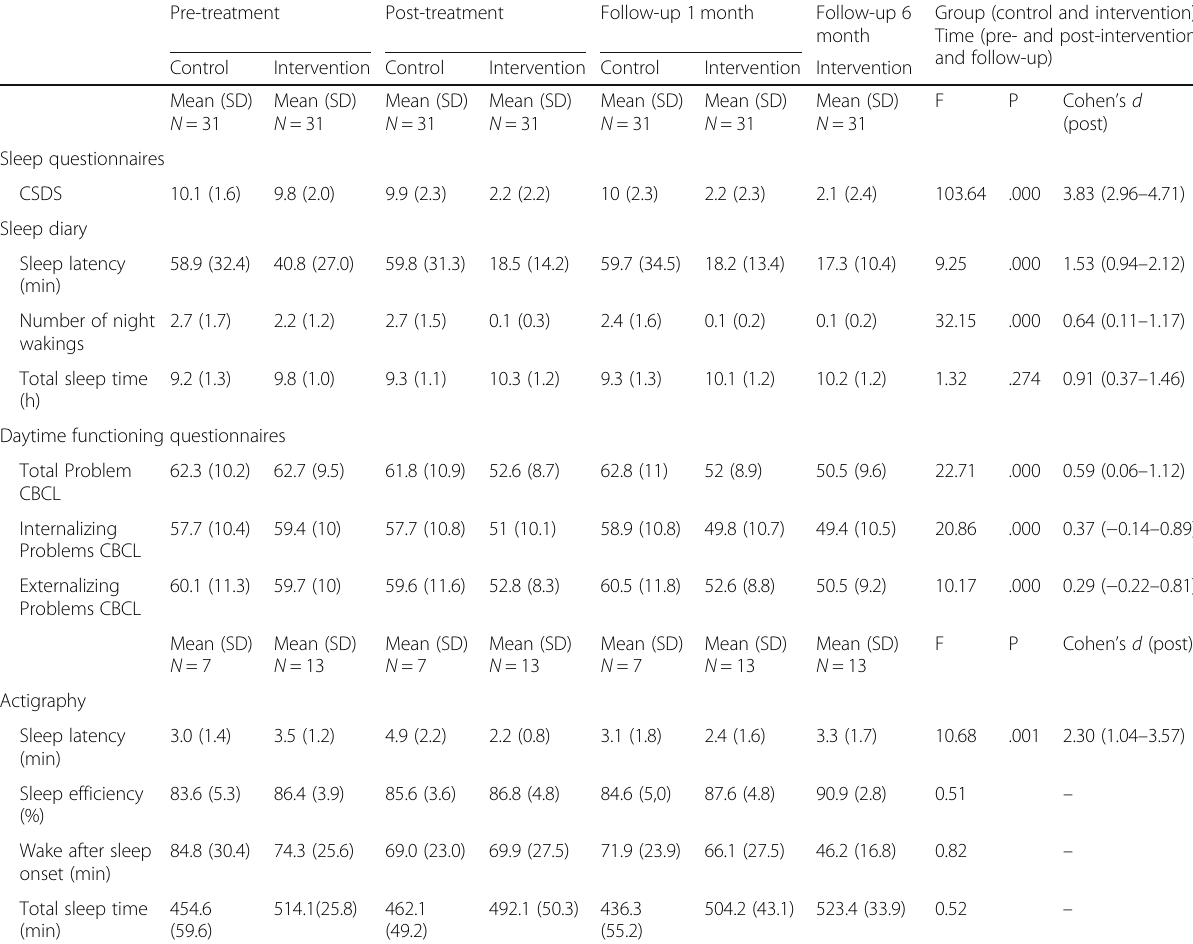
Table 3 Primary and secondary outcome measures in the first phase of the protocol